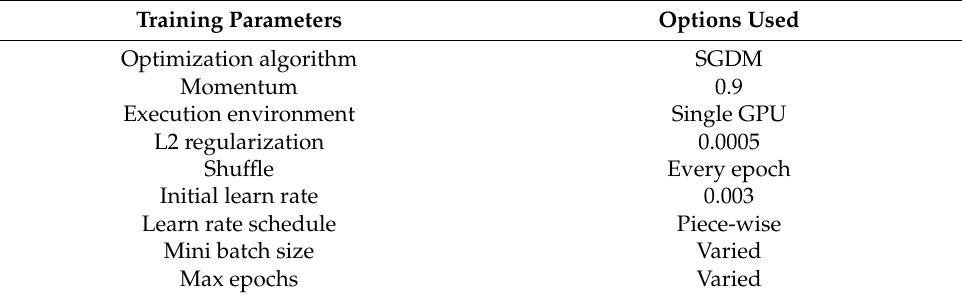
Table 2. Training parameters used in the training process of the dataset.